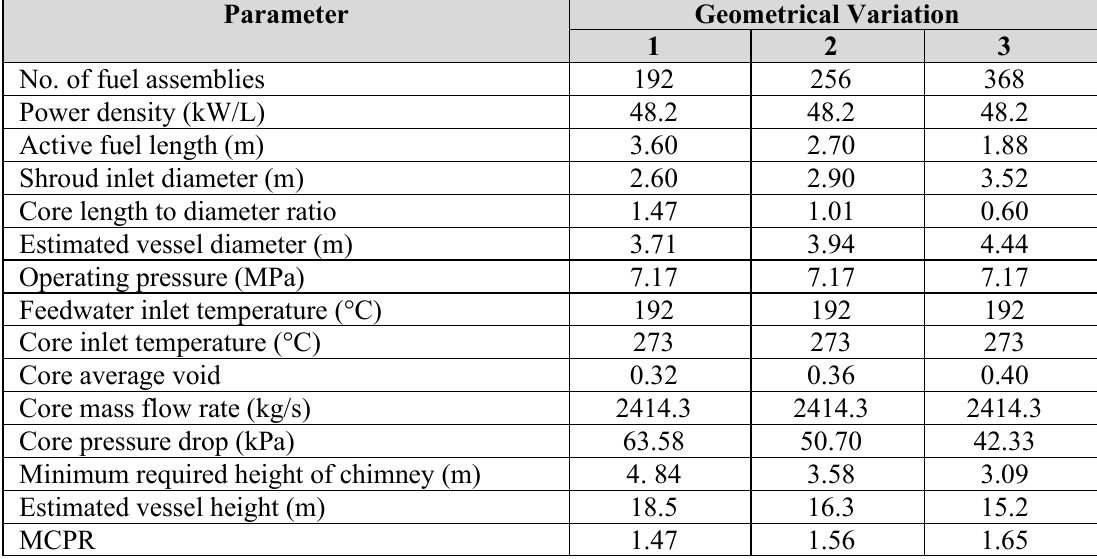
Table II. Thermal hydraulic performance comparison for the studied